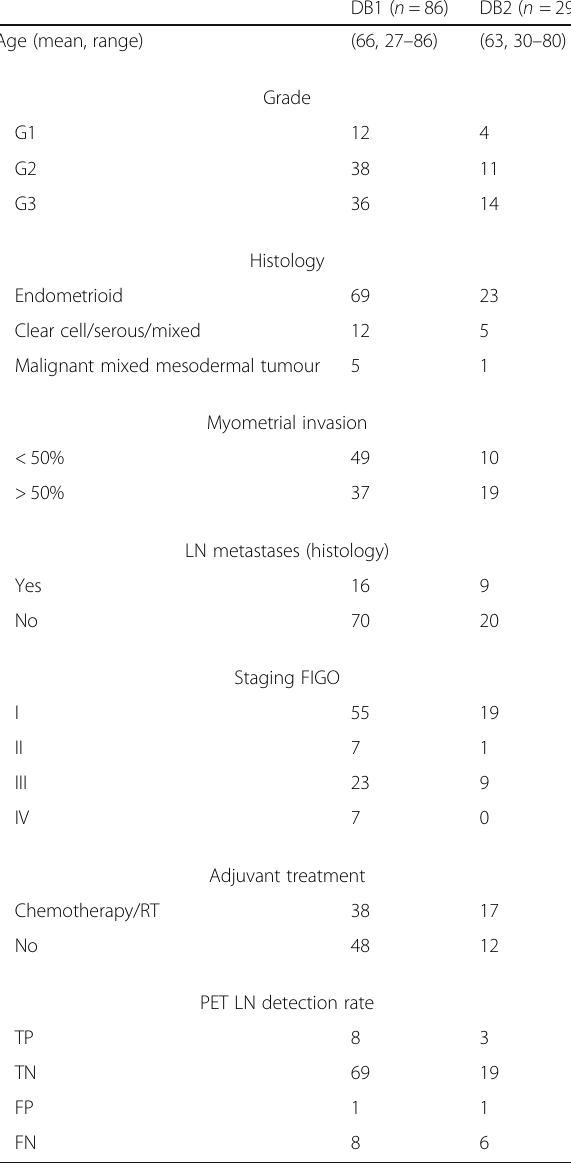
Table 1 Characteristics of DB1 and DB2 patient